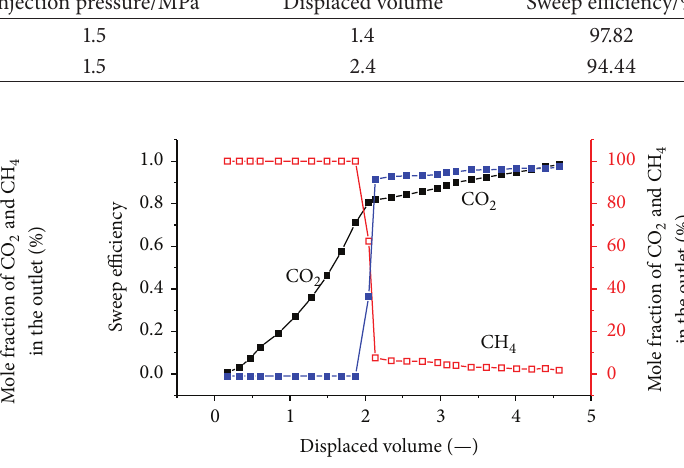
Figure 9: The sweep efficiency and concentrations of produced gas against displaced volume at 1.5 MPa.